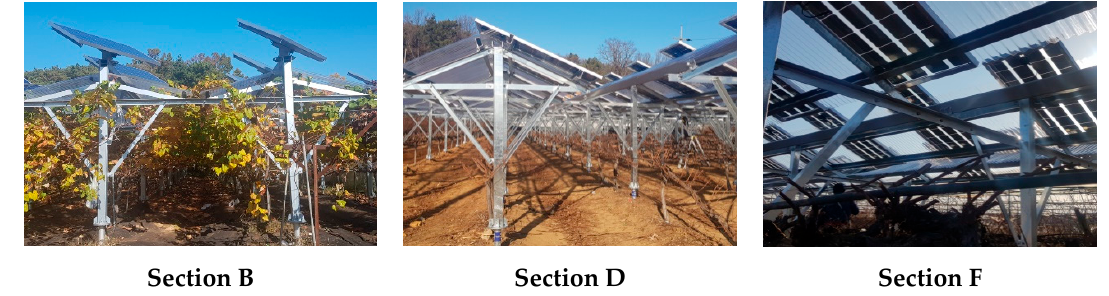
Figure 7. Three types of solar panels. B , normal type; D , bifacial type; F , transparent type.